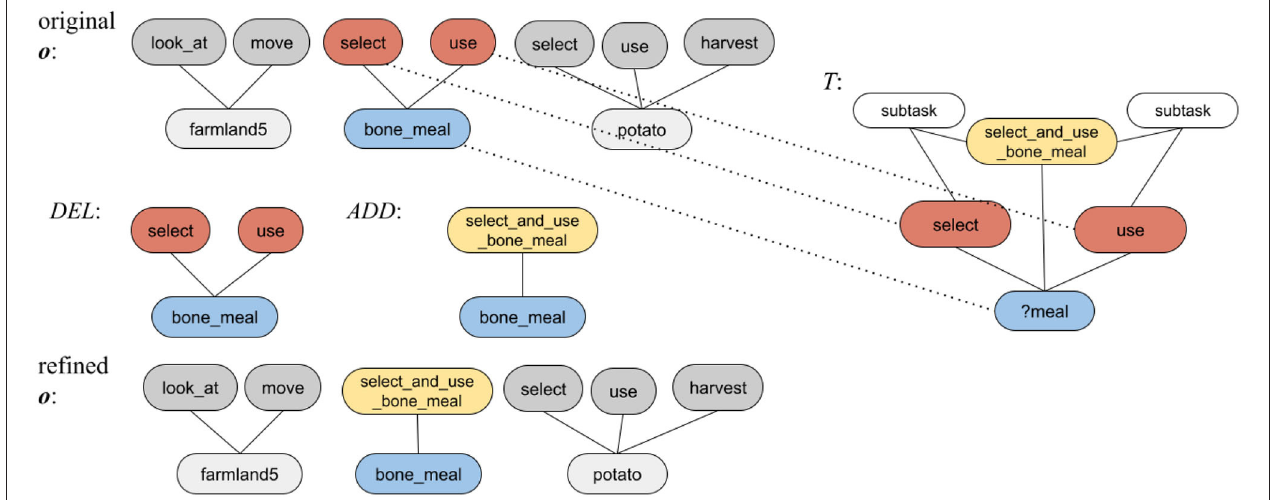
FIGURE 2 | An illustration of RAGeR recognizing the subtask select and use bone meal in an observation of an agent completing an obtain potato task. The original o is the sequence of observations [ look_at(farmland5) , move(farmland5) , select(bone_meal) , use(bone_meal) , select(potato) , use(potato) , harvest(potato) ], T is the retrieved case, DEL and ADD are the expressions being used to update o , and the refined o ′ is the updated observations, which are be used in the next round of refinement.